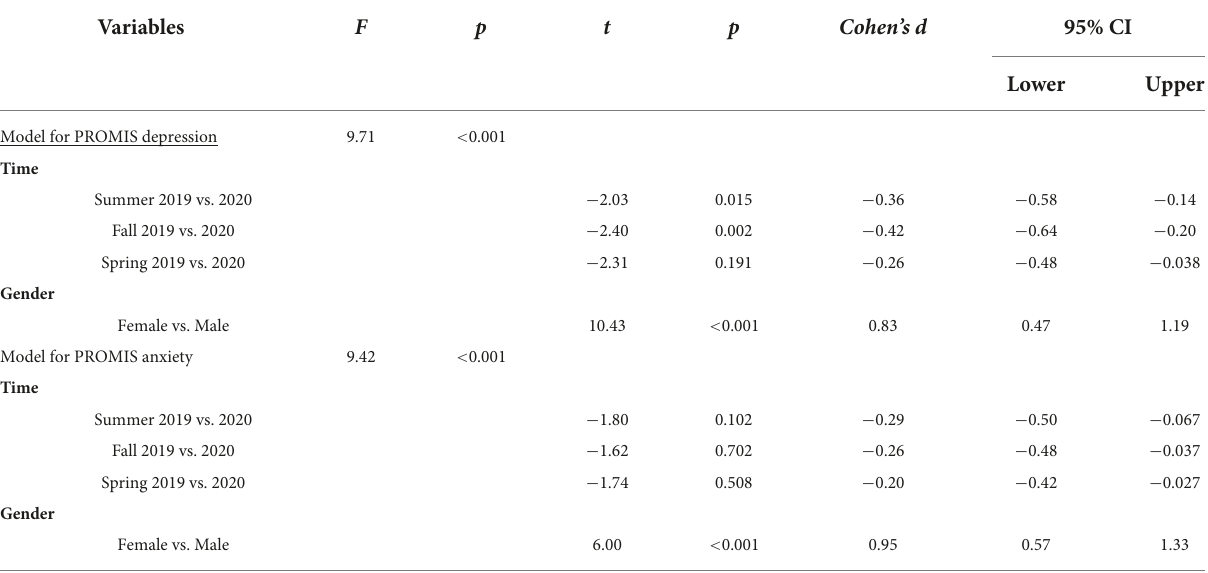
Supplementary Table 3 for statistical results for all subscales), though only the active coping and behavioral